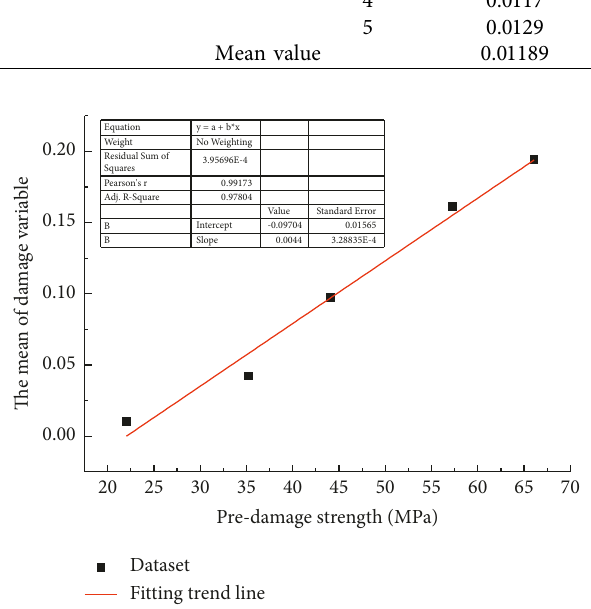
Figure 11: Damage variable on v p . Figure 12: Damage variable on ( W )